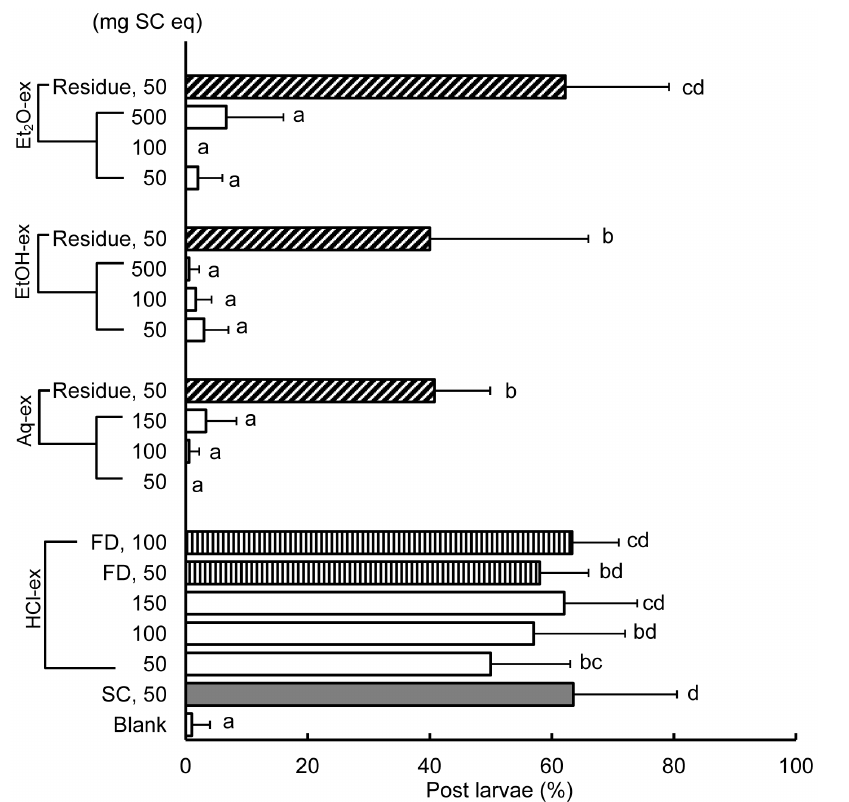
Figure 5. Percentages of post larvae on Et 2 O-ex, EtOH-ex, Aq-ex, HCl-ex and residues after extraction of C.gigas SC. Amounts assayed are expressed in mg equivalent of SC (mg SC eq), where each weight equivalent of the extract corresponds to the amount of SC extracted. Et 2 O-ex, EtOH-ex, Aq-ex and HCl-ex indicate C. gigas SC extracts with diethyl ether, ethanol, water and hydrochloric acid, respectively. FD HCl-ex indicates freeze dried HCl-ex. Data are means of 6 to 15 replicates and error bars represent standard deviations (SD). Letters indicate results of the post hoc Tukey HSD test. Groups connected by the same letter are not significantly different (p $ 0.05).